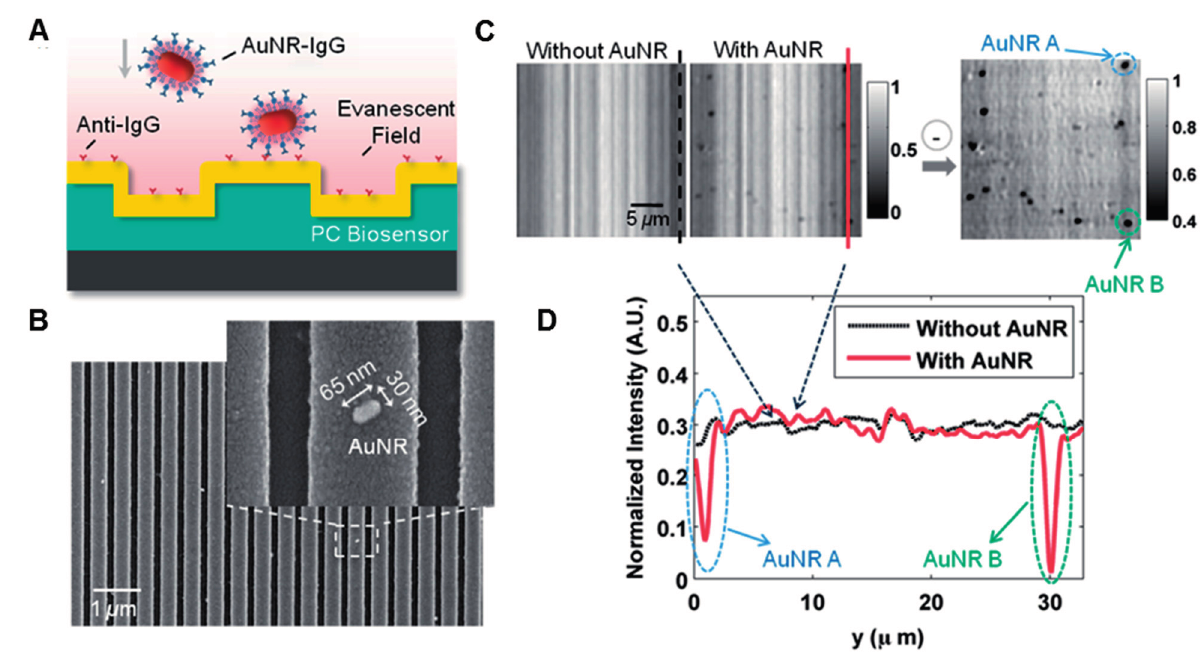
Figure 6. PCEM detection of protein-protein binding. ( A ) Schematic illustration of the PCEM detection of protein-protein binding on the PC biosensor surface; ( B ) SEM images of AuNR-IgG (AuNR conjugated with SH-PEG-IgG) attached to the PC biosensor surface. Inset: zoomed-in image for one AuNR; ( C ) PCEM-detected peak intensity value (PIV) images (in grayscale) and the PIV-shift image indicating AuNR-IgG attached on the PC surface; ( D ) Two representative cross-section lines of the normalized intensity images with/without two AuNRs-IgG on the PC surface (Reprinted in part with permission from [48], © 2014 RSC